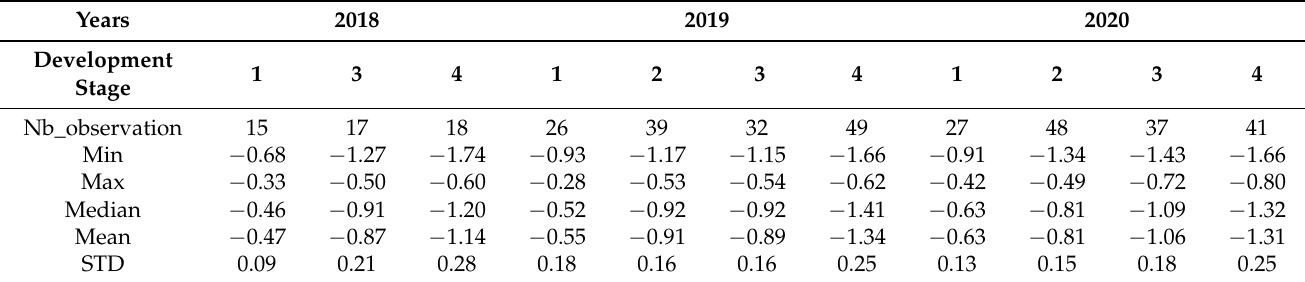
Table 7. Statistic description of SWP values for each development stage of each year (STD: standard